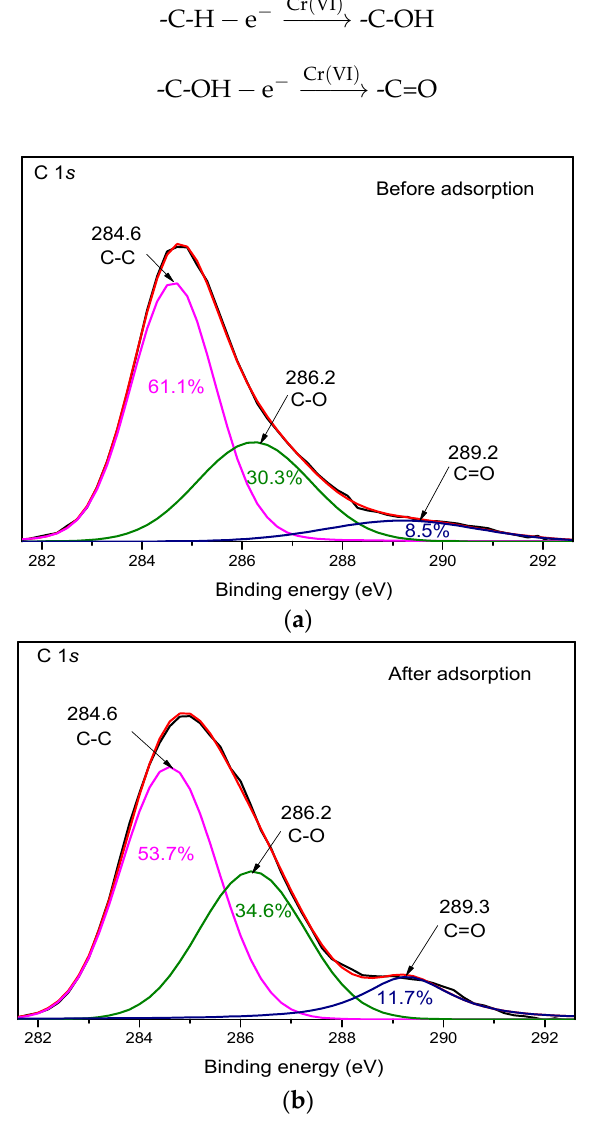
Figure 6. High-resolution XPS spectra of C 1 s for WPAC (( a , b ) before and after Cr(VI) adsorption, respectively, at pH 3).